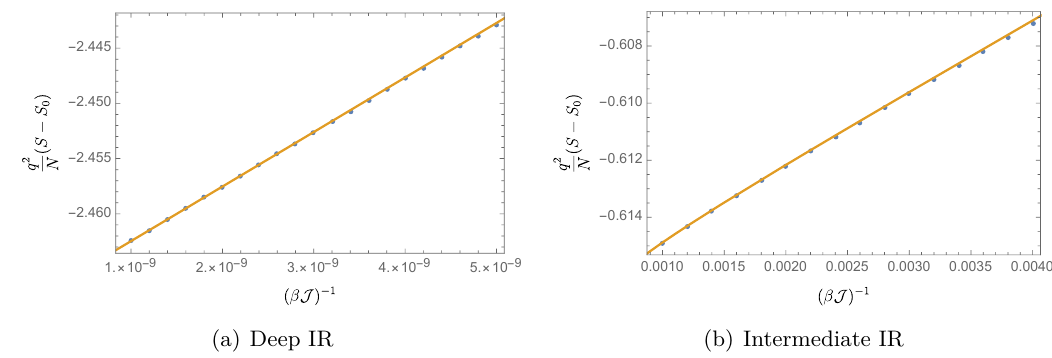
Figure 2 . Entropy as a function of the temperature in the two linear regimes. The blue dots corre- spond to the exact evaluation of (5.26), while the solid yellow lines correspond to the approximations in (5.28) and (5.29). In both cases we fix s 2 = 10 − 6